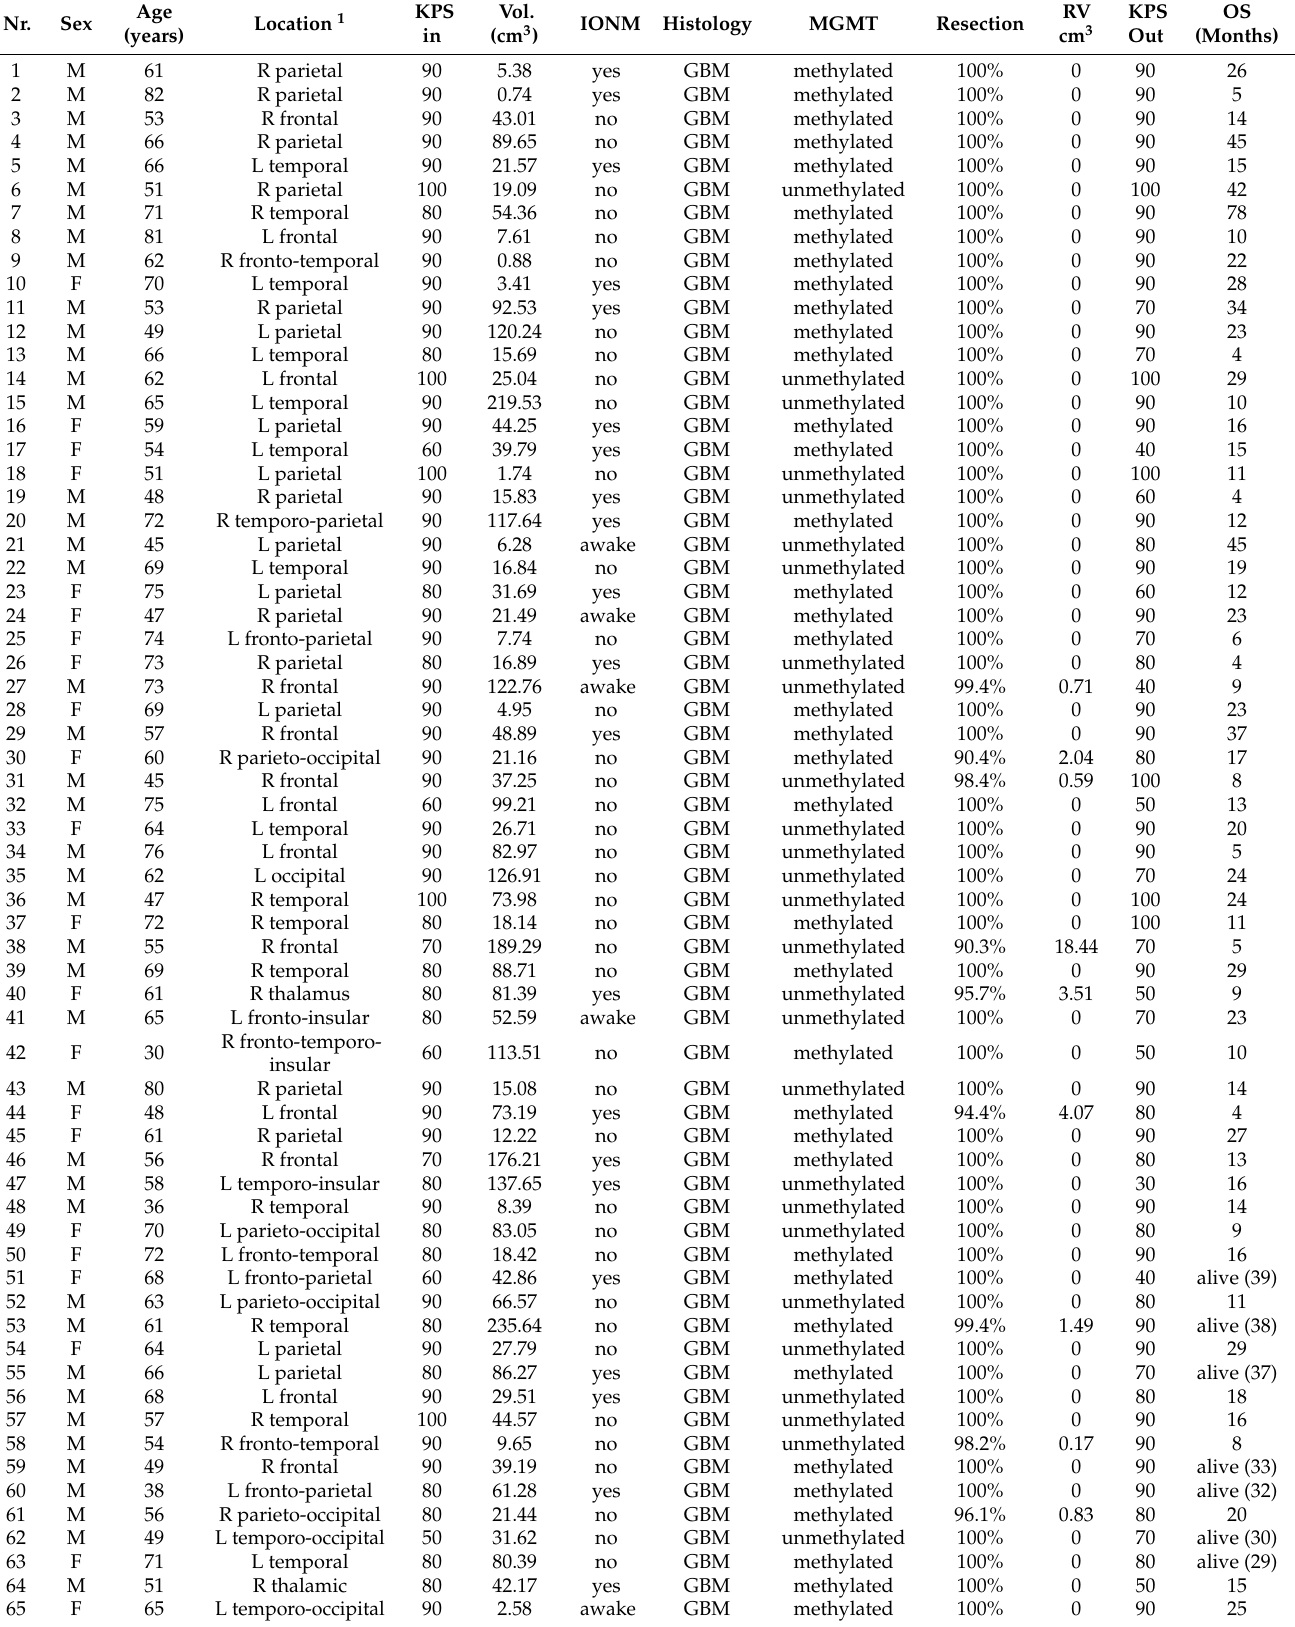
Table 1. Summary of patient demographics, resection data, and